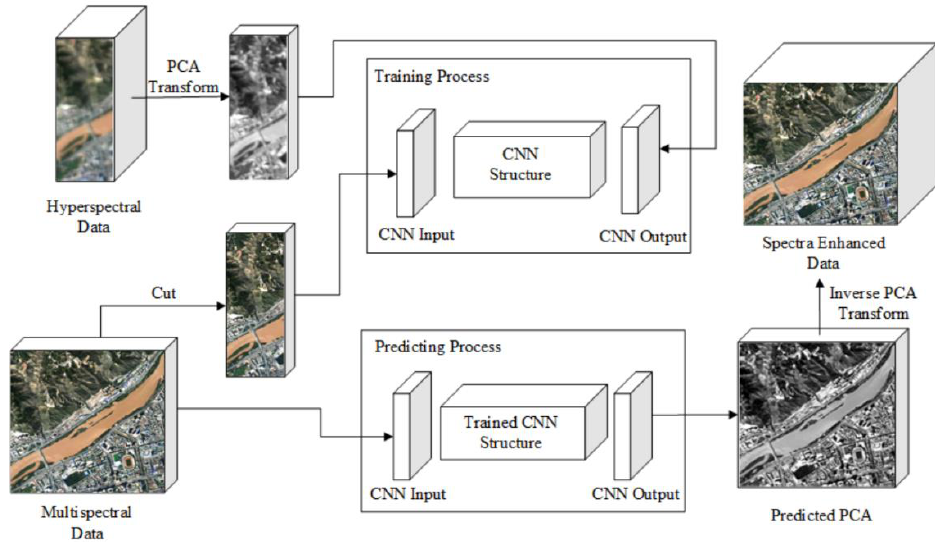
Figure 2. Basic framework of SRE-ResNet.